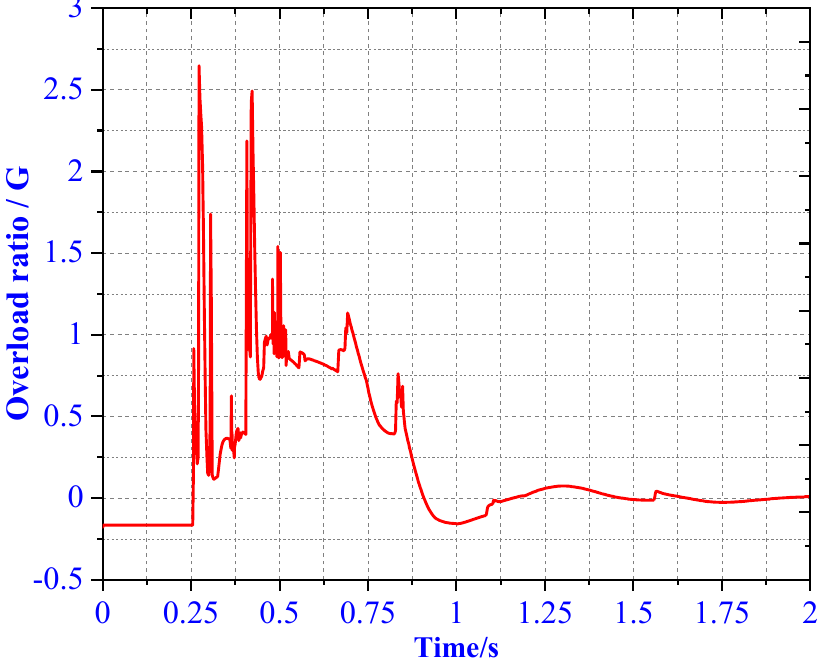
Figure 19. Overload rate of 2-2 type landing.